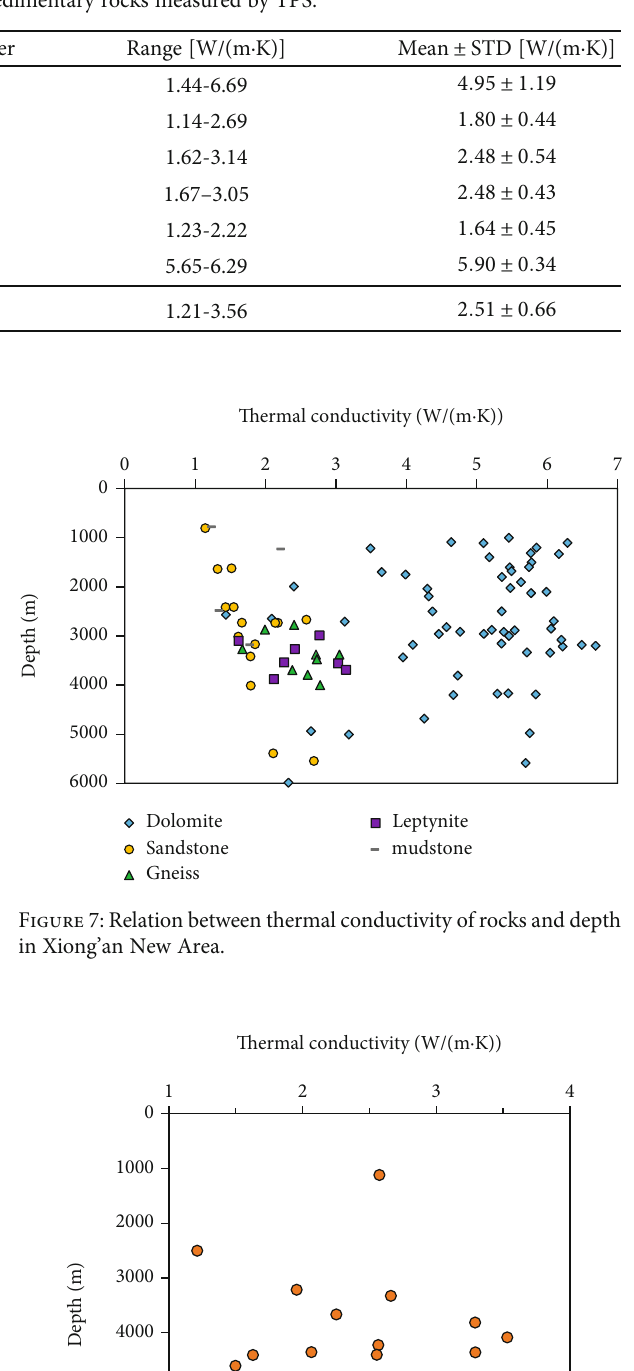
Table 1: Thermal conductivity of sedimentary rocks measured by TPS.